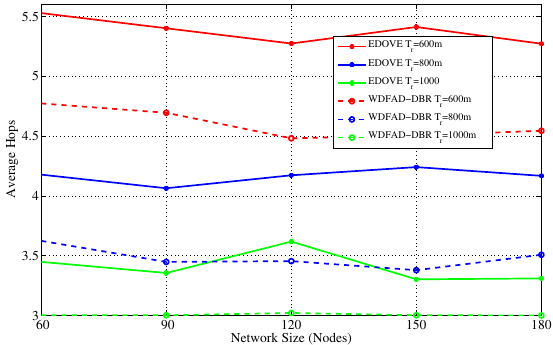
Figure 21. Average No. of Hops data messages traversed versus the network